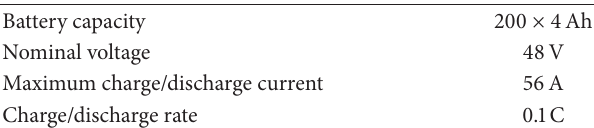
Table 6: VRLA parameter.